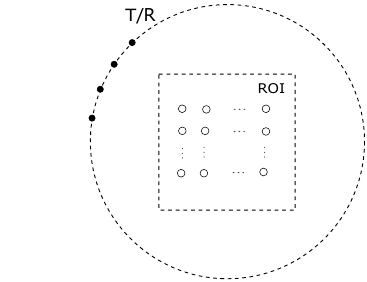
Figure 1. Illustration of the experiment in an anechoic chamber ( left ) and 2D modeling ( right